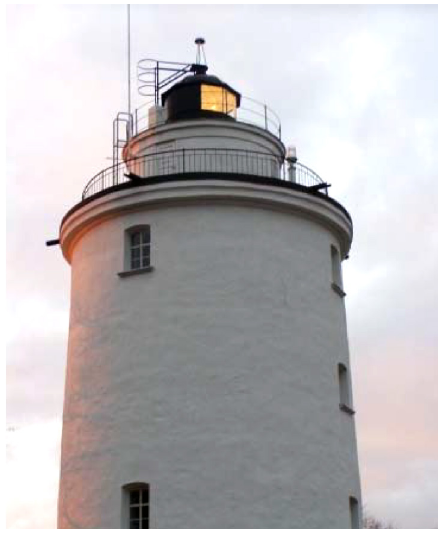
Figure 1. Suurupi lighthouse with the GNSS antenna mounted on the rooftop (Ellmann, 1997)